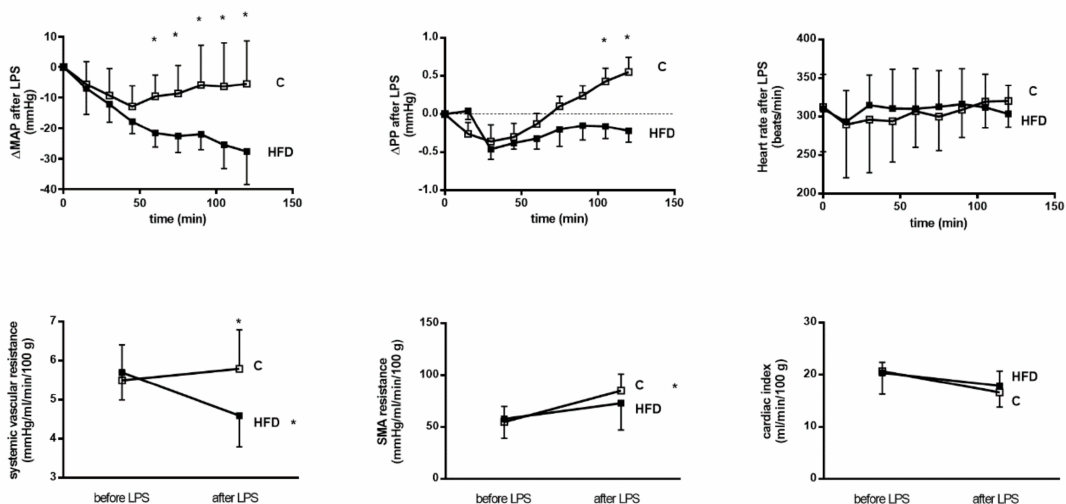
Figure 4. The hemodynamic response to lipopolysaccharide (LPS) injection. The changes of mean arterial pressure ( ∆ MAP), portal pressure ( ∆ PP) and HR ( ∆ HR) were monitored for 120 min after LPS injection. The MAP dropped at first in both groups. After 60 min, MAP was compensated in the control group but remained low in the HFD group. The ∆ MAP was significantly higher in control group at 120 min. The PP changed in the same trend. The heart rate (HR) was not significantly di ff erent between the two groups. The systemic vascular resistance (SVR) and superior mesenteric artery (SMA) resistance were significantly lower in the HFD group after LPS injection (HFD group, before LPS v.s. after LPS; t-test). (* p < 0.05).